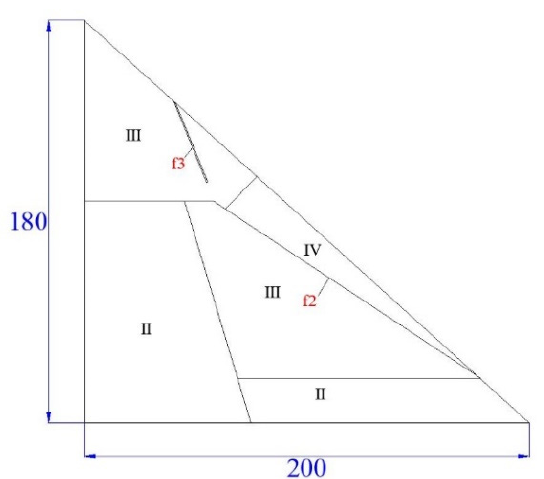
Figure 2. Physical model diagram (cm). II: Class II rock mass. III: class III rock mass. IV: class IV rock mass.